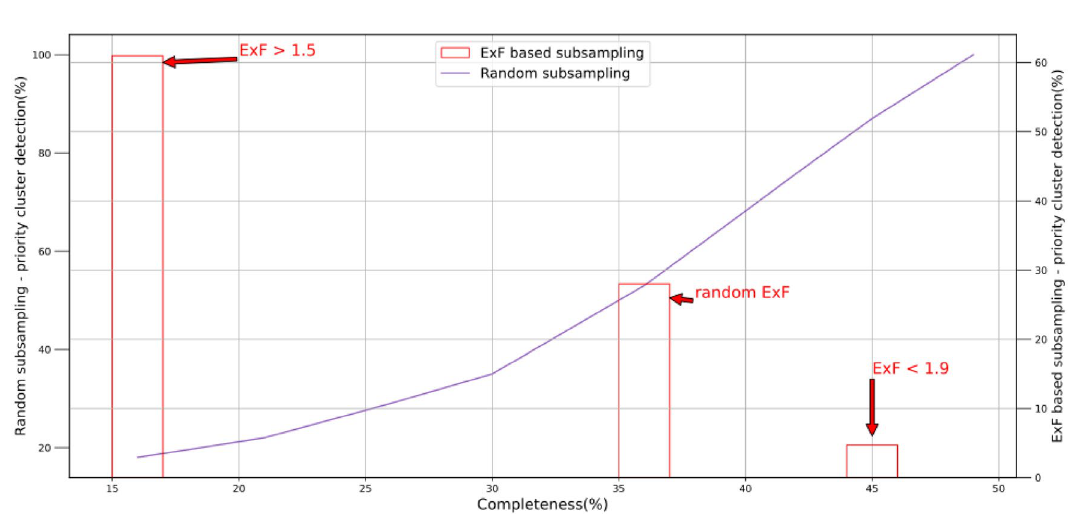
Figure 5. Cluster detection comparison for two sampling methods (Houston/Harris county 2012–2019): Left Y axis shows priority clusters detected in Randomly subsampled data, Right Y axis shows priority clusters detected from subsampled data based on Expected Force (ExF) node influence